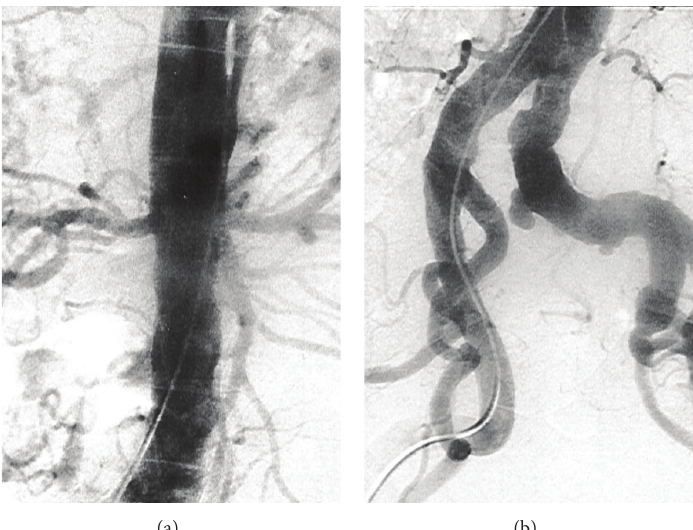
Figure2:Arteriographyshowingdiffuseareasofnarrowinganddilationoftheabdominalaorta(a)andsignificantdilationoftheleftcommon iliac artery (b).